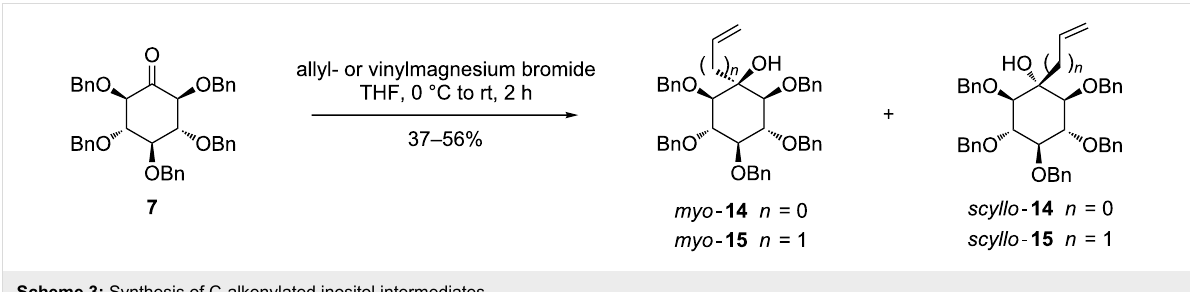
Scheme 3: Synthesis of C-alkenylated inositol intermediates.